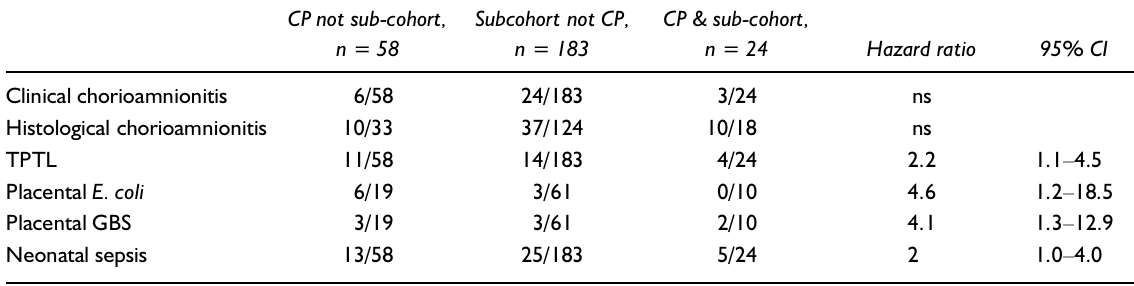
Table 1 Histological and microbiological